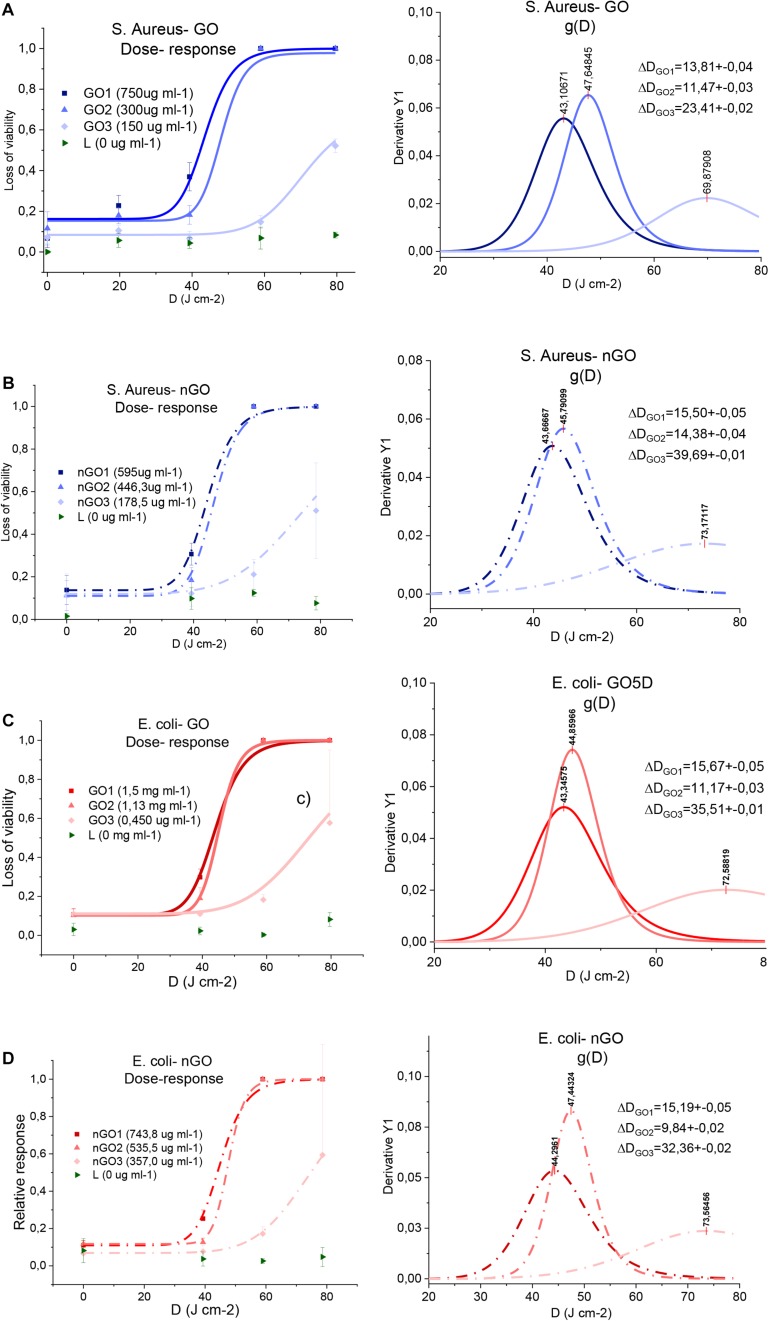
Dose-response curves and the threshold dose distribution. (A)
S. aureus-GO, (B)
S. aureus-nGO, (C)
E. coli-GO, and (D)
E. coli-nGO.